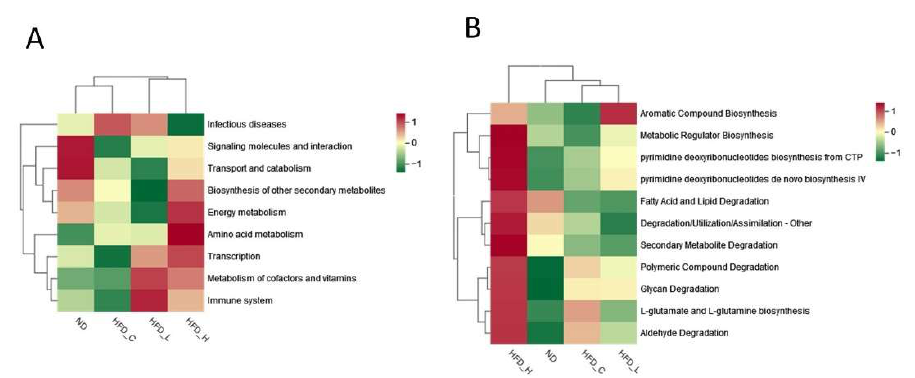
Figure 5. Functional relative abundance of intestinal flora based on the Kyoto Encyclopedia of Genes and Genomes (KEGG) and Metabolic Pathways from All Domains of Life (MetaCyc) databases. ( A ) Heatmap of metabolic function clustering of KEGG. ( B ) Heatmap of metabolic function clustering of MetaCyc.